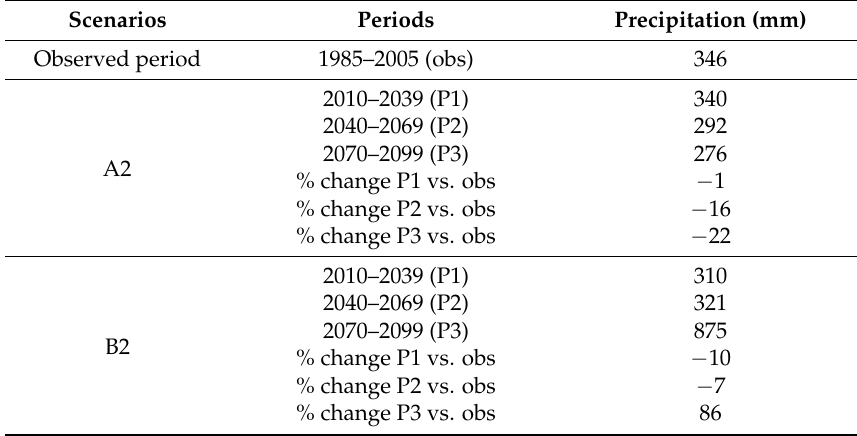
Table 5. Results of the annual precipitation predictions of the HadCM3 scenarios for the